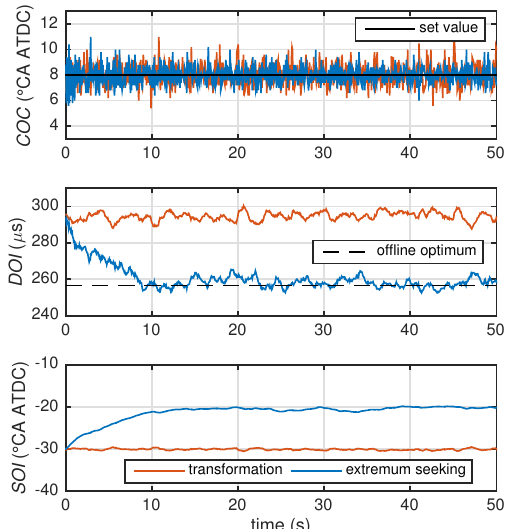
Figure 14. Comparison of the transformation method and the fast excitation approach based on extremum seeking presented in this paper. The alternative operating point given in Table 3 is used, i.e. , the operating point other than the one used for the identification of the transformation. For the extremum seeking approach, the start of injection SOI is shown without the excitation